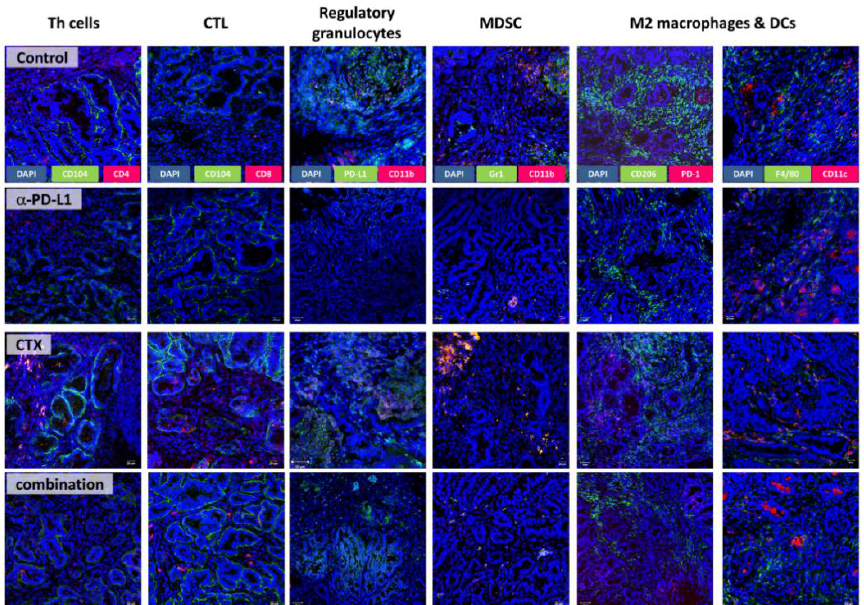
Figure 5. Immunofluorescence. Mlh1 − / − GIT cryostat sections of 4 µ m were prepared and the tumor microenvironment was studied upon staining with specific monoclonal antibodies, followed by nuclear staining with DAPI. Images were taken using a laser scanning microscope, Elyra PS.1 (Zeiss), and 20× objective.